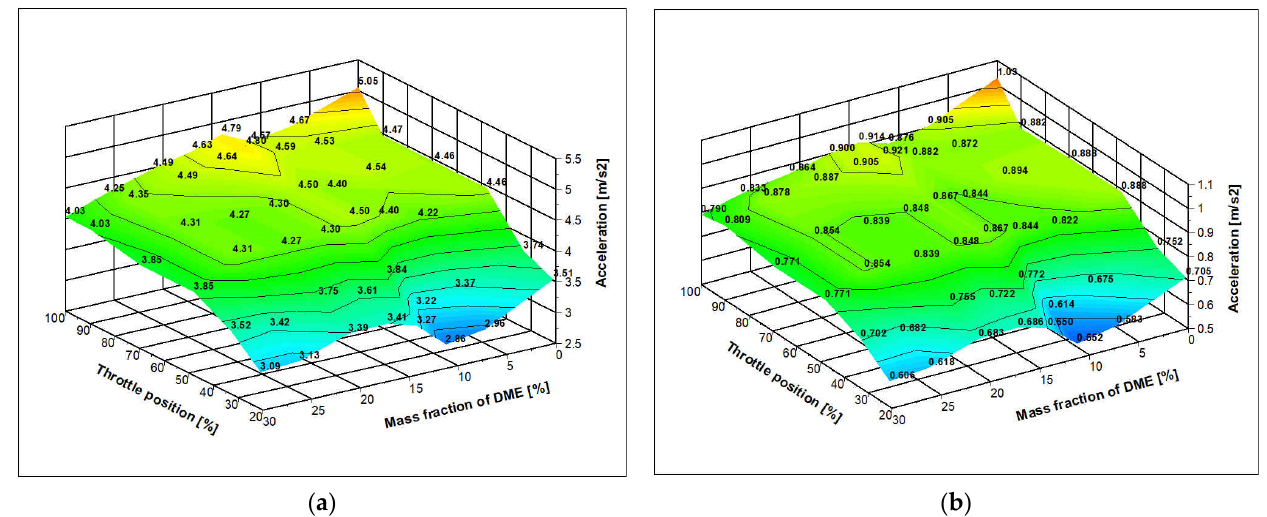
Figure 12. Maximum values of the acceleration for different mass fraction of DME and engine load ( a ) first gear, ( b ) fifth gear.